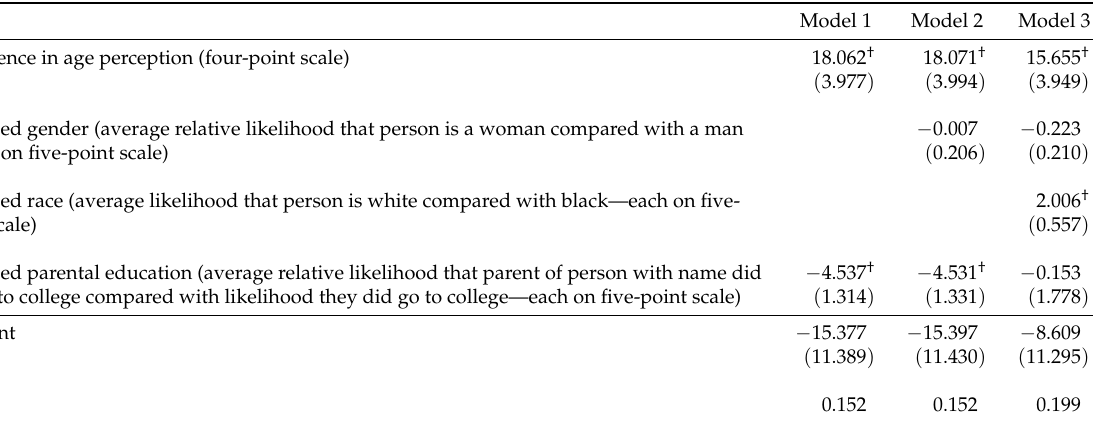
Table 2: Ordinary least squares regression predicting the age perception of a name by other perceived